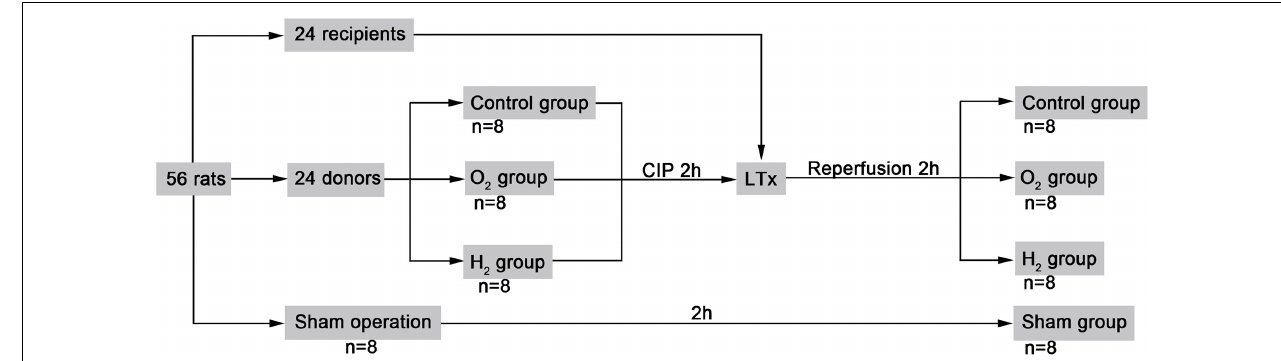
FIGURE 1 | Study design. The control group, natural collapsed donor lung; The 0 2 group, donor lung inflation with 40% oxygen; The H 2 group, donor lung inflation with 40% oxygen and 3% hydrogen; CIP, cold ischemia phase; LTx, lung transplantation.